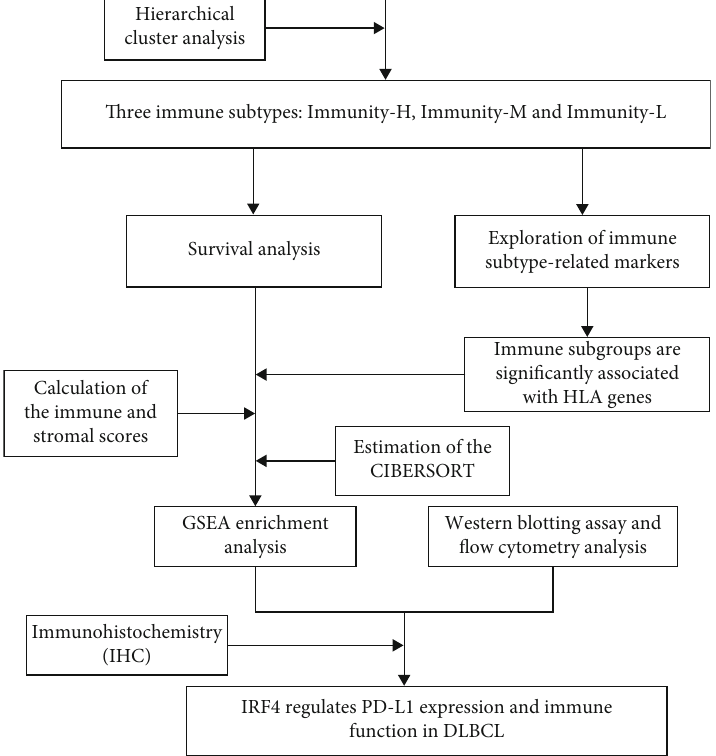
Figure 1: The follow diagram of this